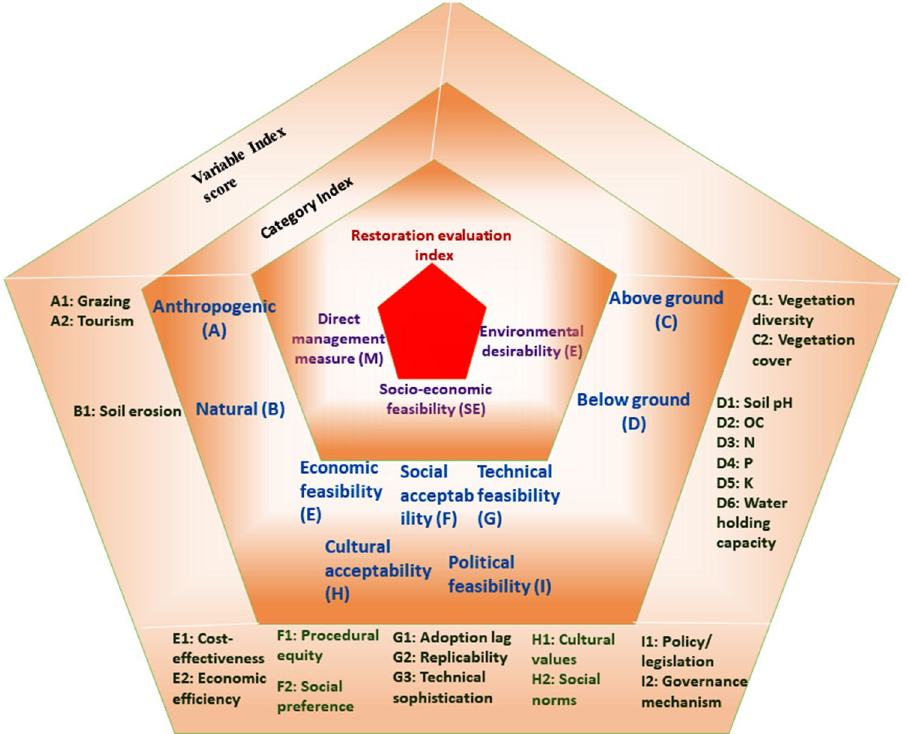
Figure 8. Detailed outline of the scoring process applied for restoration evaluation index calculation for the Dayara